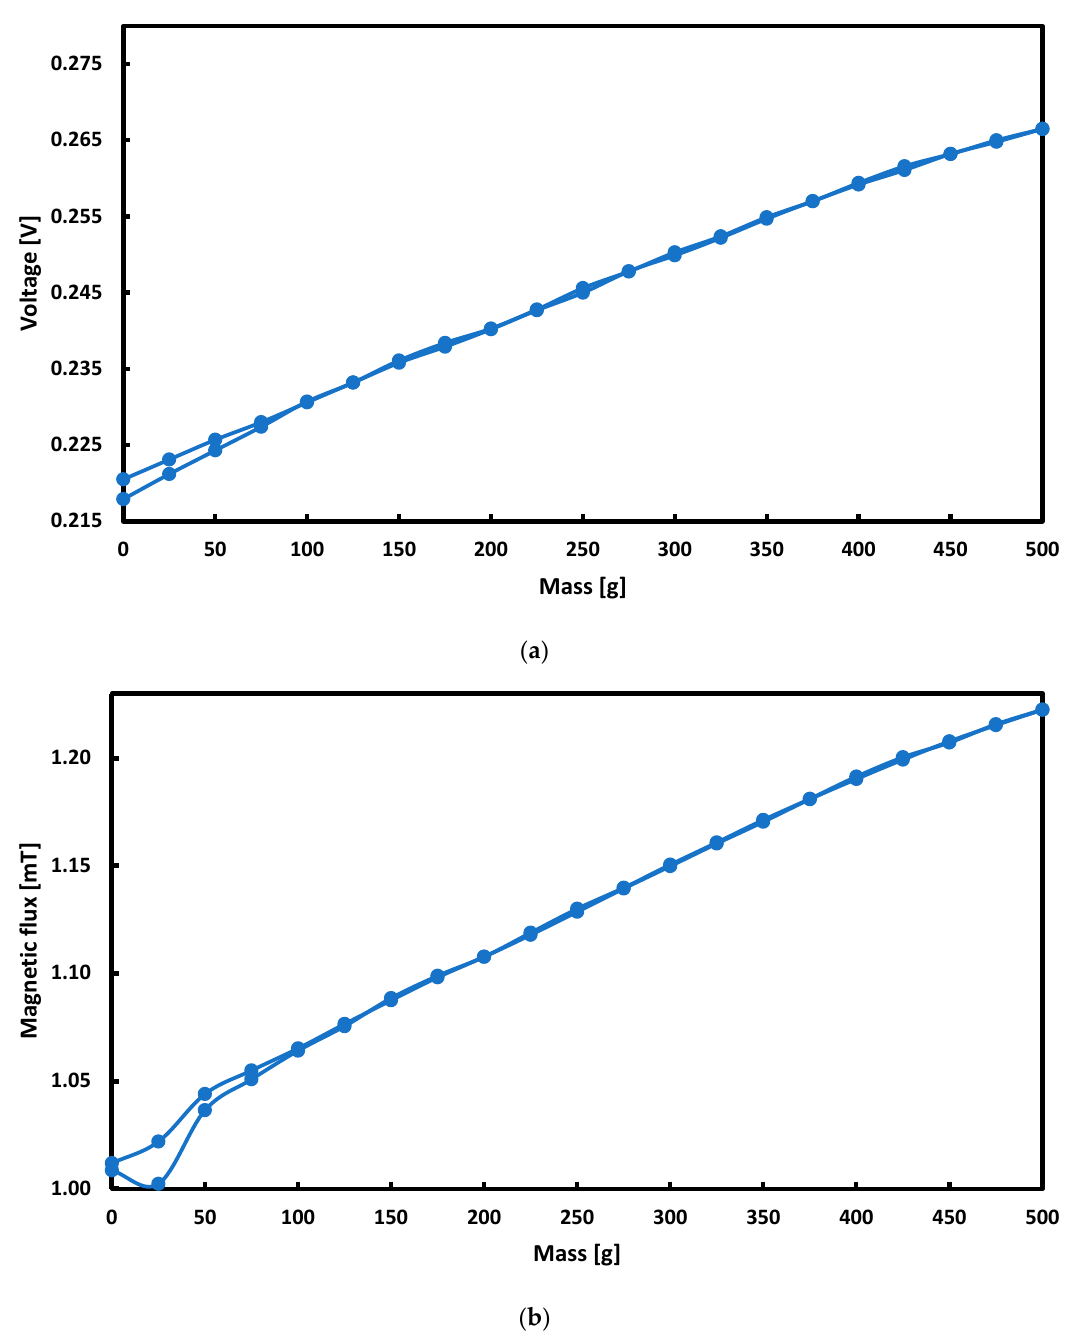
Figure 15. Measurement hysteresis curves for measuring: ( a ) voltage, ( b ) magnetic flux when magnetizing the plate with a triangular signal with a frequency of 300 Hz.